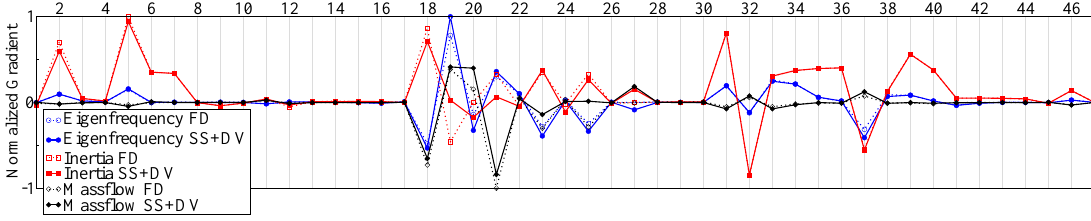
Figure 14. ∂ f e , ∂ J z , ∂ ˙ m each calculated both via finite differences (FD) and via surface sensitivities + ∂ s ∂ s ∂ s design velocities